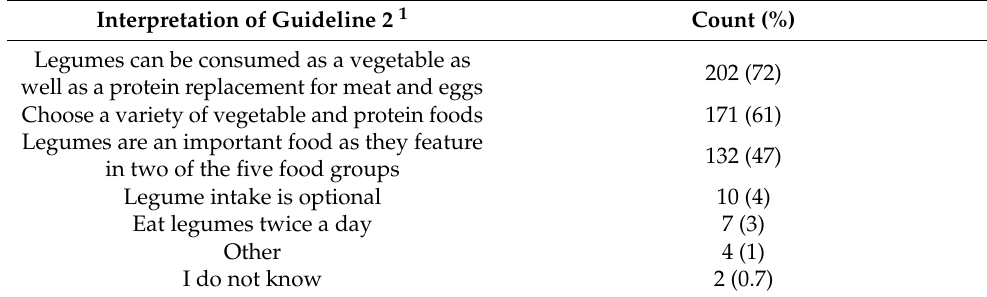
Table 3. Respondents’ interpretation of the focus of Guideline 2 for legume intake (n = 280)